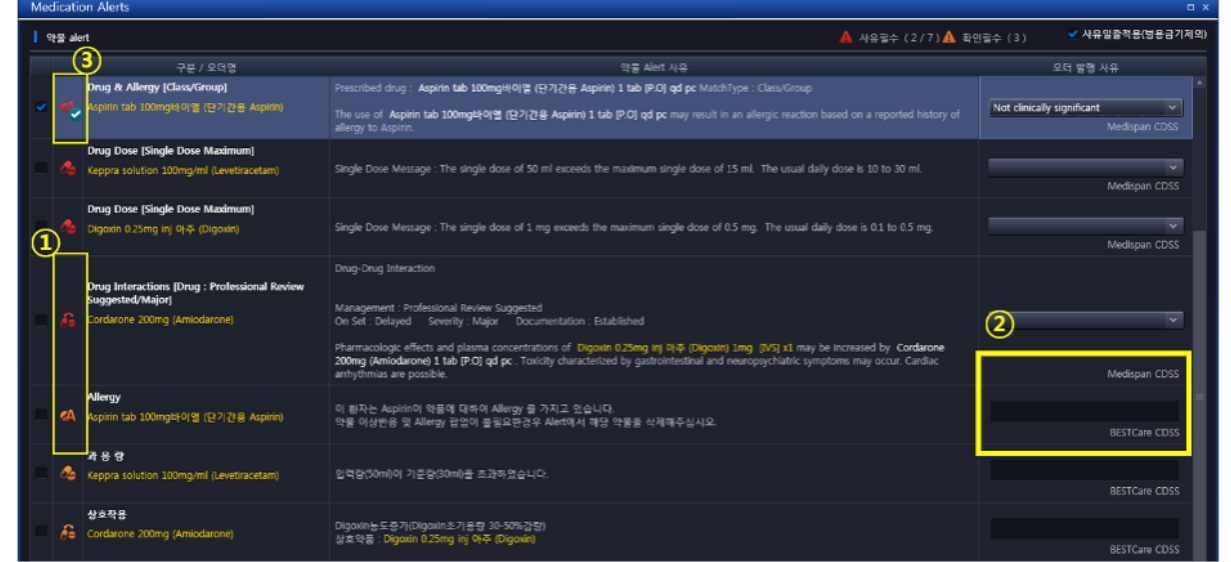
Figure 3. Screenshot of the MDSS user interface. 1) Override requirements: red alerts indicate that users must view an alert message and select a reason for overriding it, whereas orange alerts indicate that users must confirm the alert. 2) Origin of alerts: BESTCare MDSS, Medi-span CDSS, and South Korean national prescription drug monitoring program. 3) Classification of alerts using icons, allowing users to see the notification